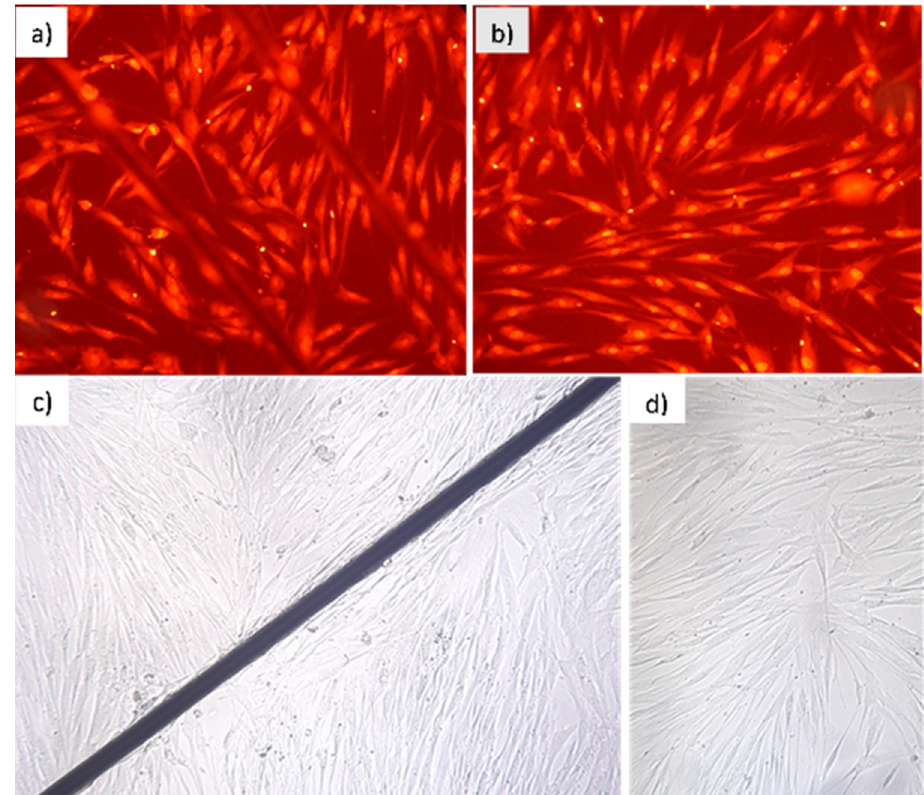
Figure 18. Assessment of cell viability in the presence of microwires ( a , c ) in comparison with control samples without the wires ( b , d ). A nutrient medium with the cell culture—human embryonic fibroblasts (FEH-T)—was used. ( a , b ) After exposure for 24 h, fluorescent staining by ethidium bromide was used to assess the survival of cells in the presence and in the absence of microwires. Luminosity was examined under a fluorescent microscope. ( c , d ) Optical microscope images after 168-h exposure demonstrate no visual effect of microwires on cell